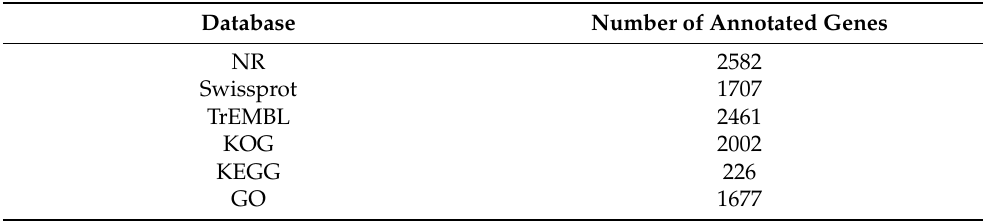
Table 1. Function annotation result statistics.